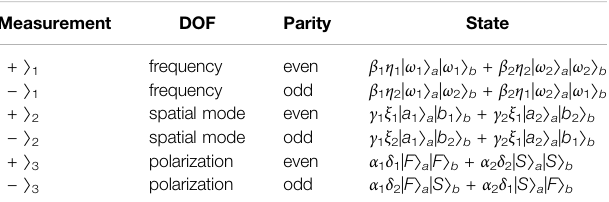
TABLE 2 | The relations between the measurement results on the three NV centers and the parity of the quantum state in the frequency, spatial-mode, and polarization DOFs, respectively.